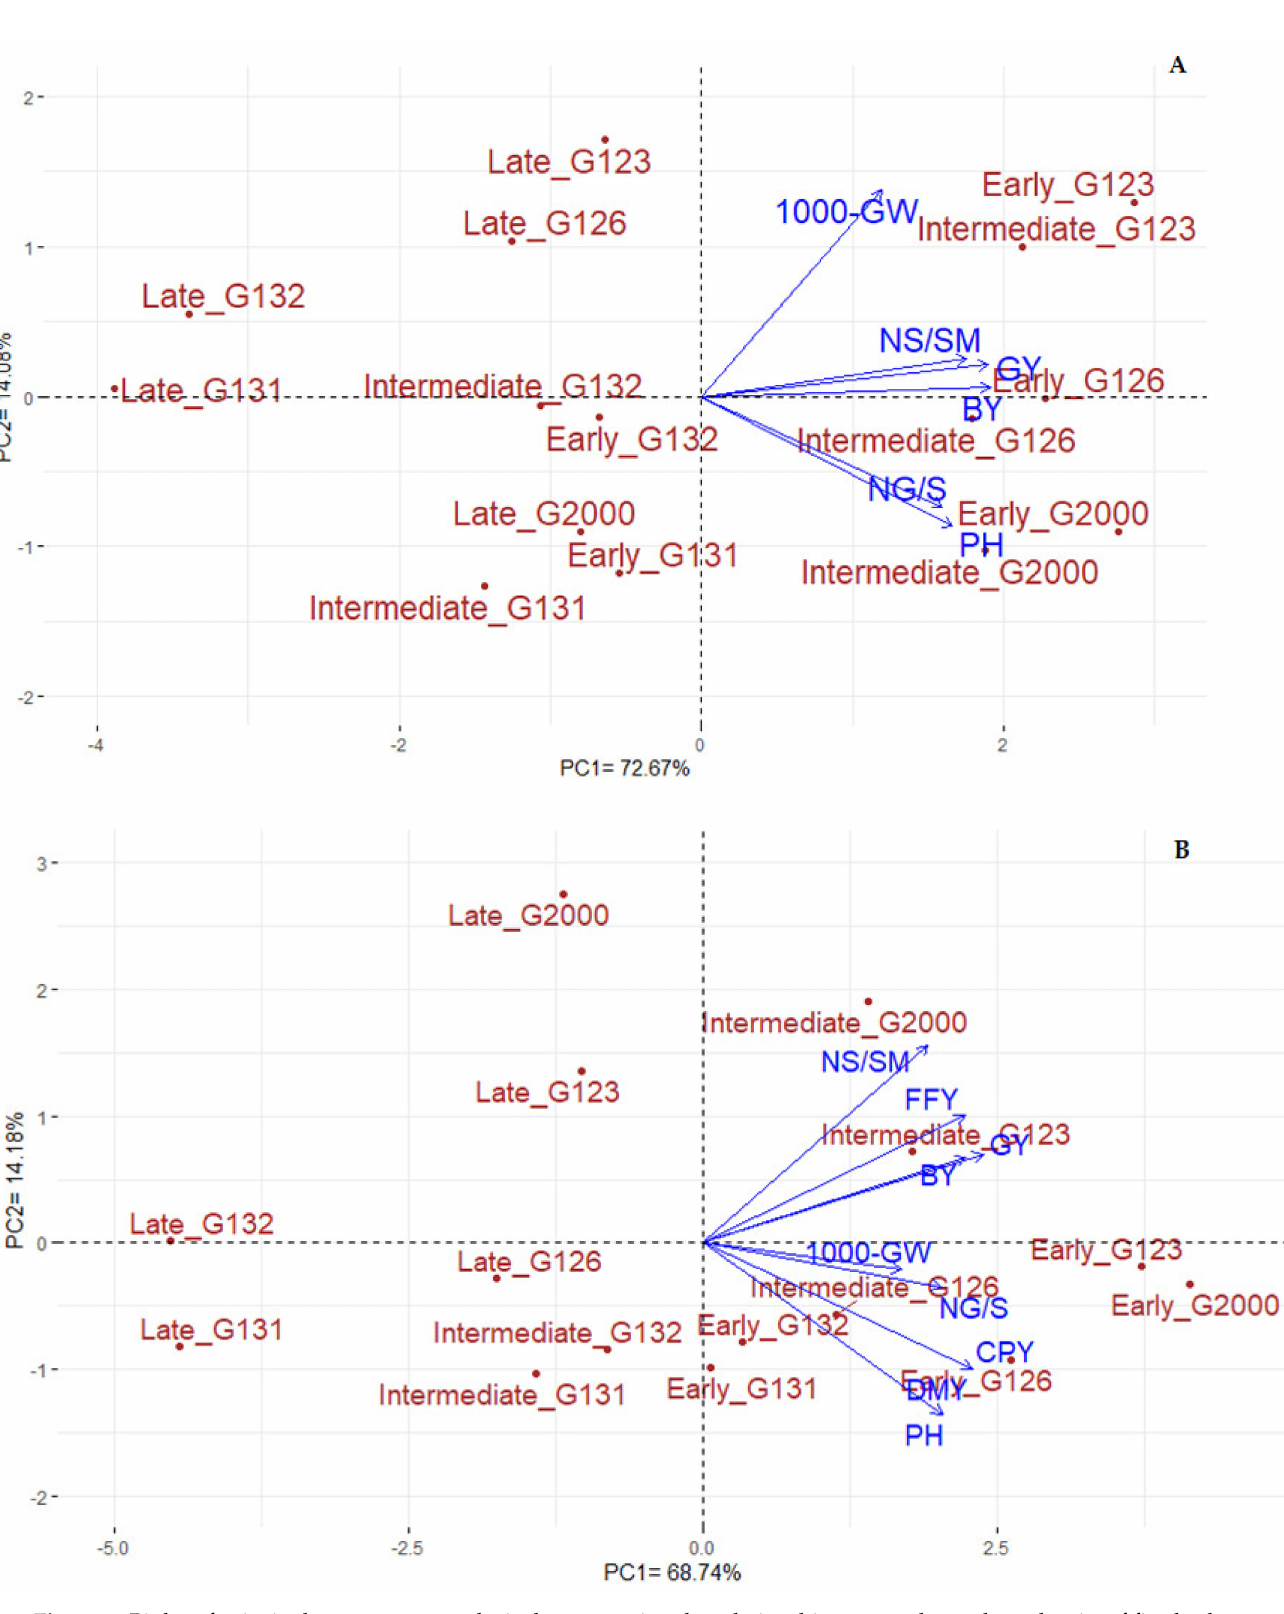
Figure 4. Biplot of principal components analysis demonstrating the relationship among the evaluated traits of five barley genotypes in only-grain ( A ) and dual-purpose ( B ) patterns under different sowing dates over averaged over the two growing seasons. PH is plant height (cm), NS/SM is number of spikes per square meter, NG/S is number of grains per spike, 1000-GW is 1000-grain weight (g), GY is grain yield (kg ha − 1 ), BY is biological yield (kg ha − 1 ), FFY is fresh forage yield (kg ha − 1 ), DMY is dry matter yield (kg ha − 1 ), and CPY is crude protein yield (kg ha − 1